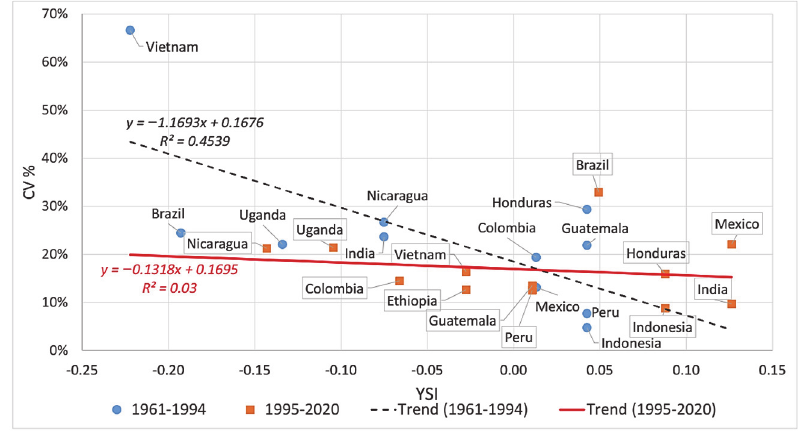
Figure 5. YSI vs. CV% scatterplot for coffee yields, 1961–1994 and 1995–2020. Source: authors’ own elaboration.